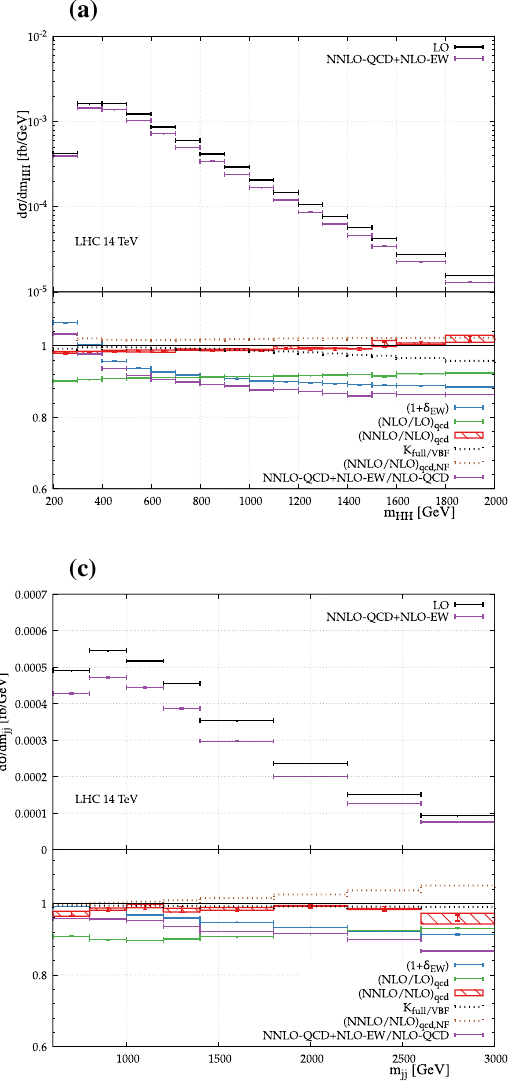
Fig. 4 Differential distributions for pp → jjHH at the LHC with centre-of-mass energy of 14 TeV: a invariant mass of the two Higgs bosons (top left), b transverse momentum of the two Higgs bosons (top right), c invariant mass of the two hardest jets (bottom left), and d rapid-